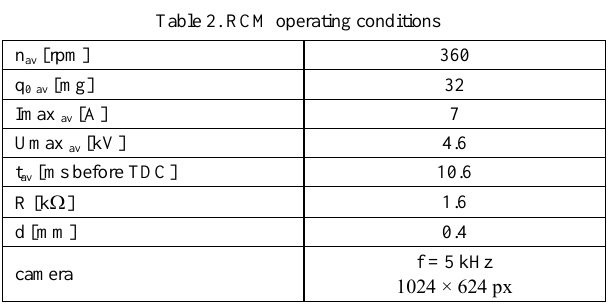
Table 2. RCM operating conditions